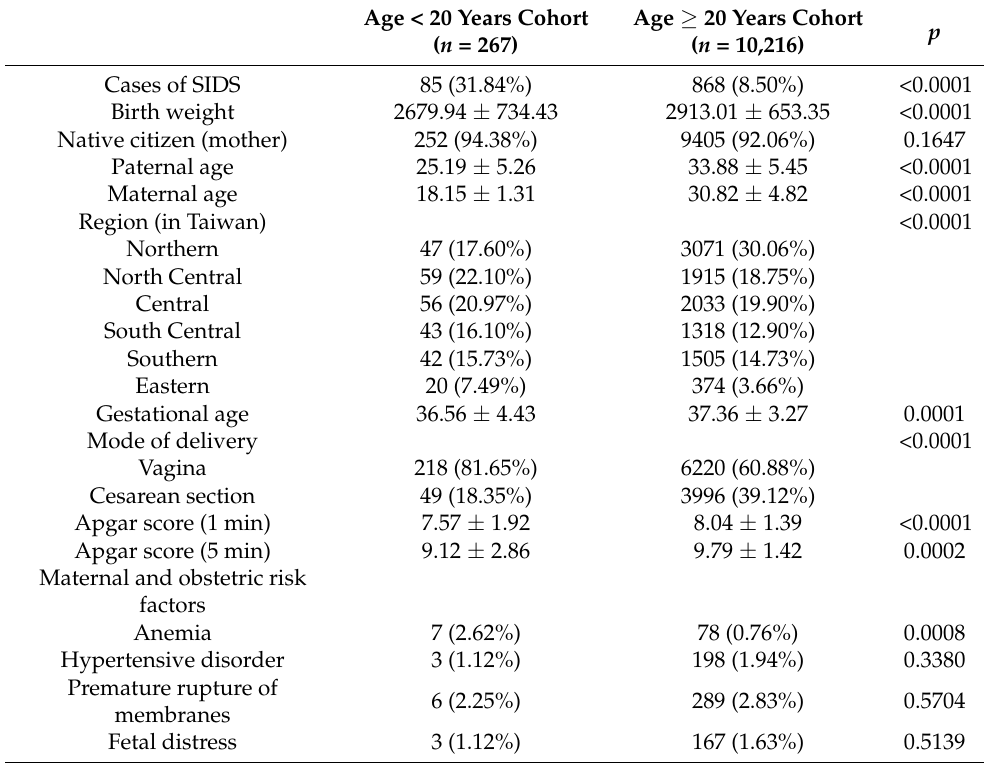
Table 3. Basal characteristics between the two groups divided by maternal age (<20 and ≥ 20